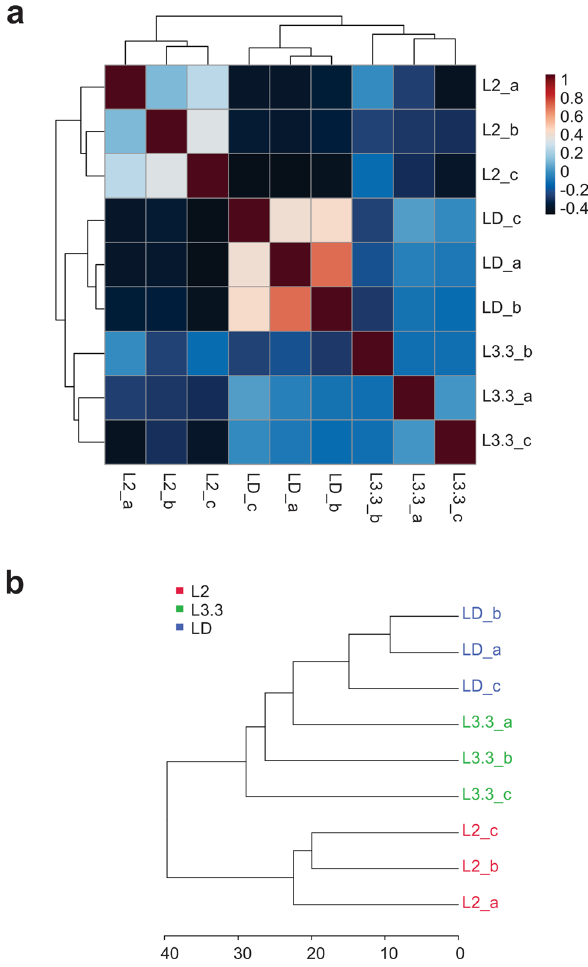
Figure 4. Correlation of metabolomic profiles of each sample of Melipona scutellaris larvae. Correlation heatmap of samples ( a ) and Hierarchical Clustering Dendrogram of samples ( b ). L2 = larva of the second stage; L3.3 = larva of the third stage in the third instar; LD = defecating larva.